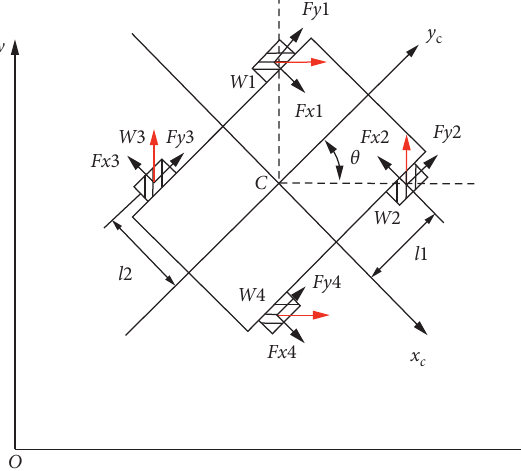
Figure 1: Structure diagram of the mobile